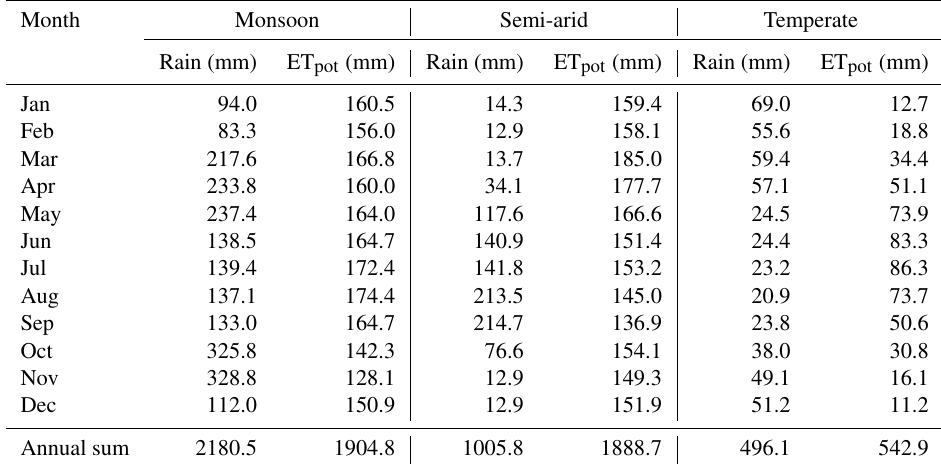
Table 1. Average cumulative monthly and annual rainfall and potential evapotranspiration of the three test climates calculated from 1000 years of generated weather records.